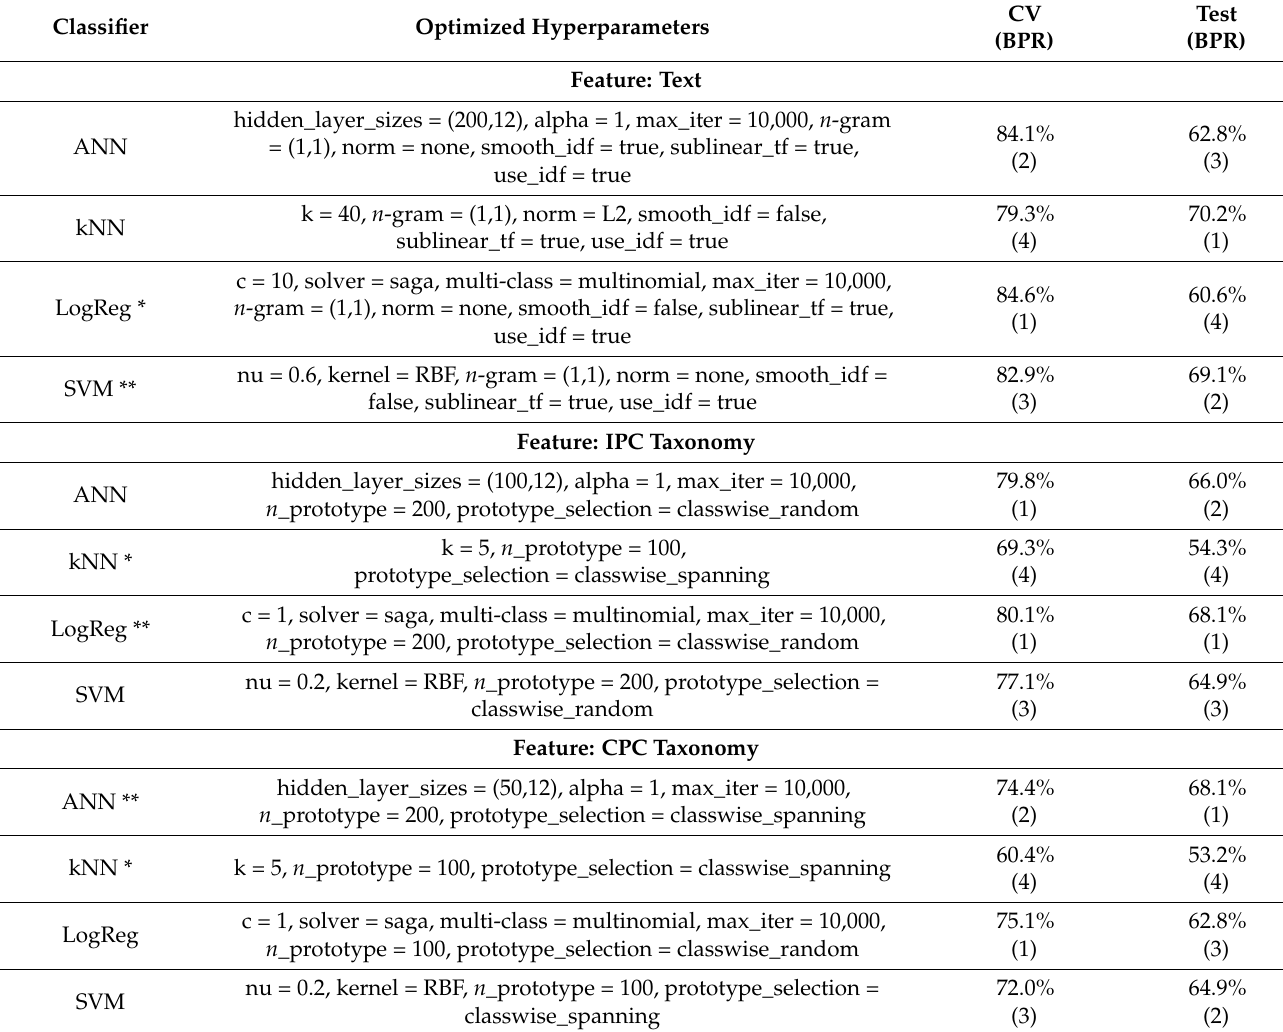
Table A1. Results of hyperparameter tuning of the base classifiers: feed-forward Artificial Neural Network (ANN), k- Nearest-Neighbor (kNN), Logistic Regression (LogReg), and Support Vector Machine (SVM). The F1 scores for testing and 10-fold cross-validation (CV) were ranked (values in parentheses: Base Performance Ranking, BPR) for each feature. The summed BPR are used to select top (**) and bottom (*) ranked classifiers to build ensemble pairs for final